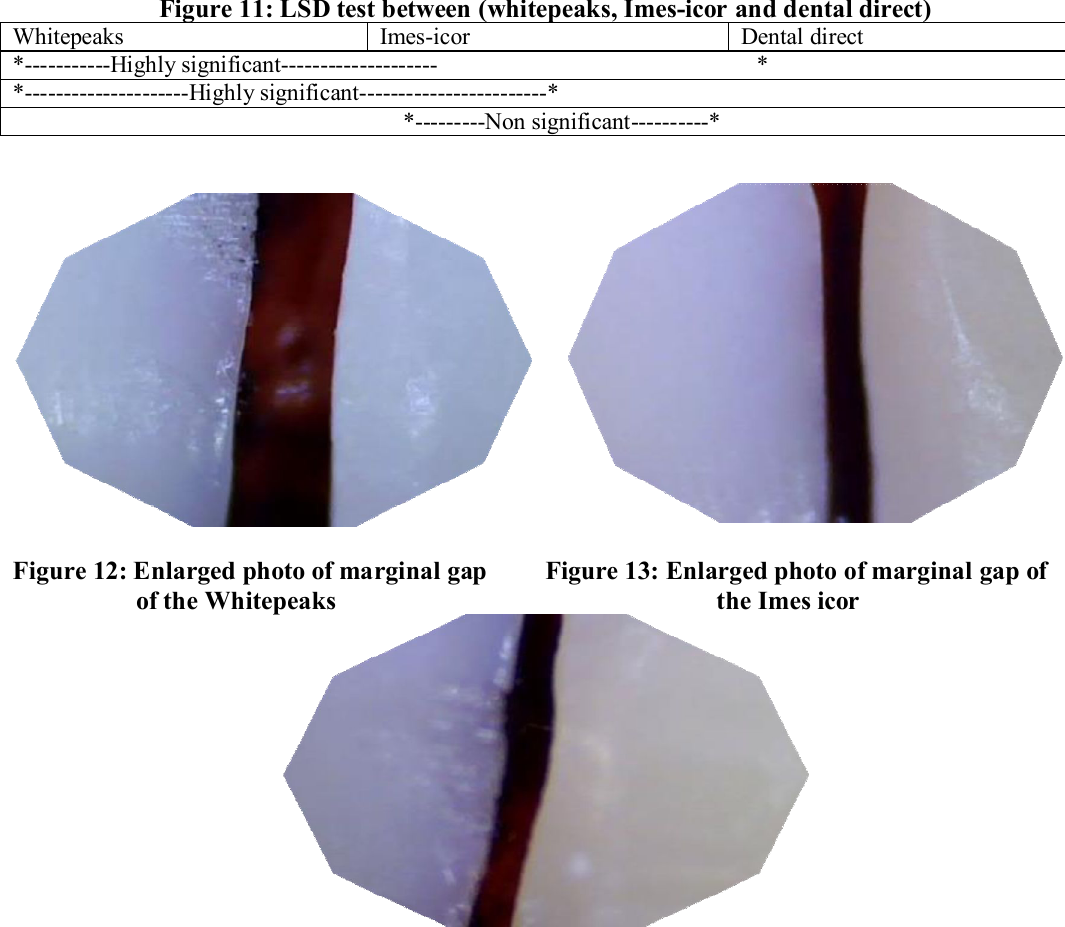
Figure 14: Enlarged photo of marginal gap of the Dental